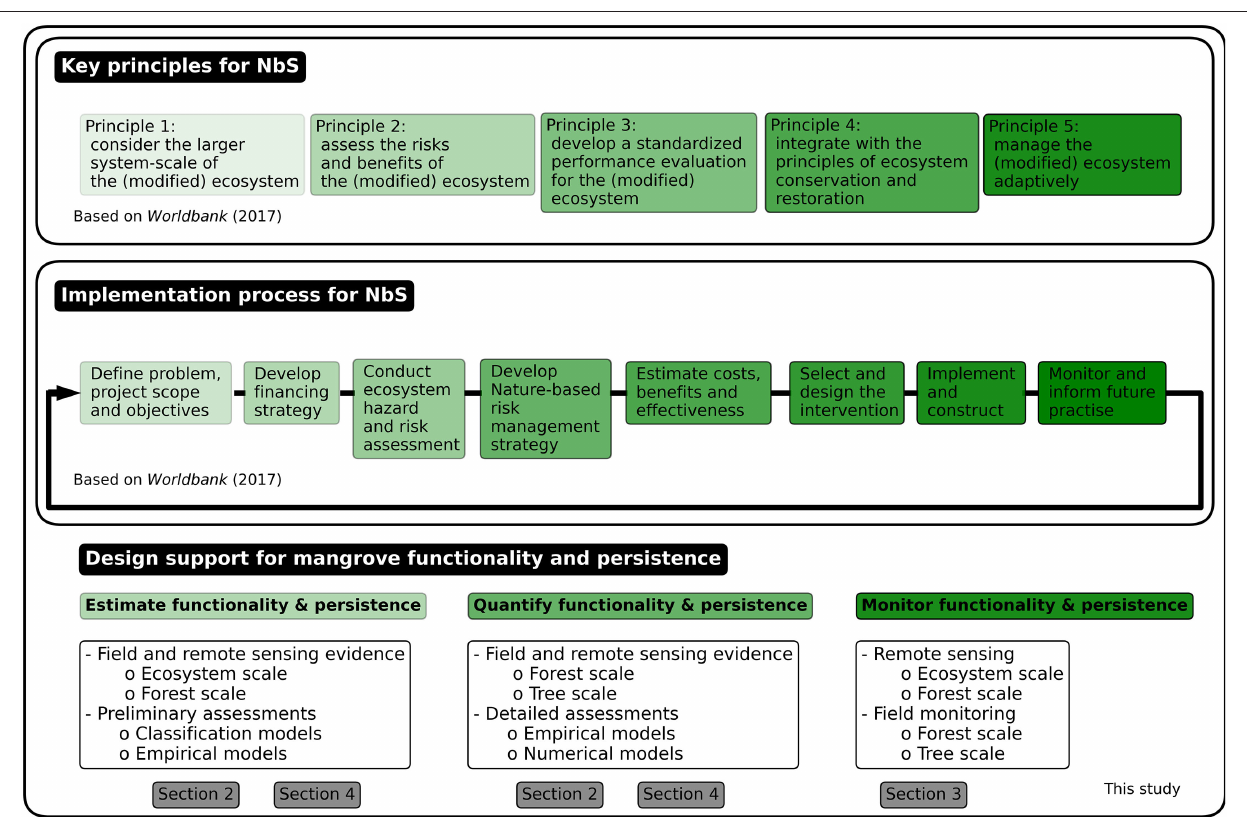
FIGURE 5 | Key principles and implementation steps for NbS to reduce coastal flood risk, based on World Bank (2017). This review has addressed design support and tools for mangroves. The green shading indicates when these can be operationalized in existing frameworks and